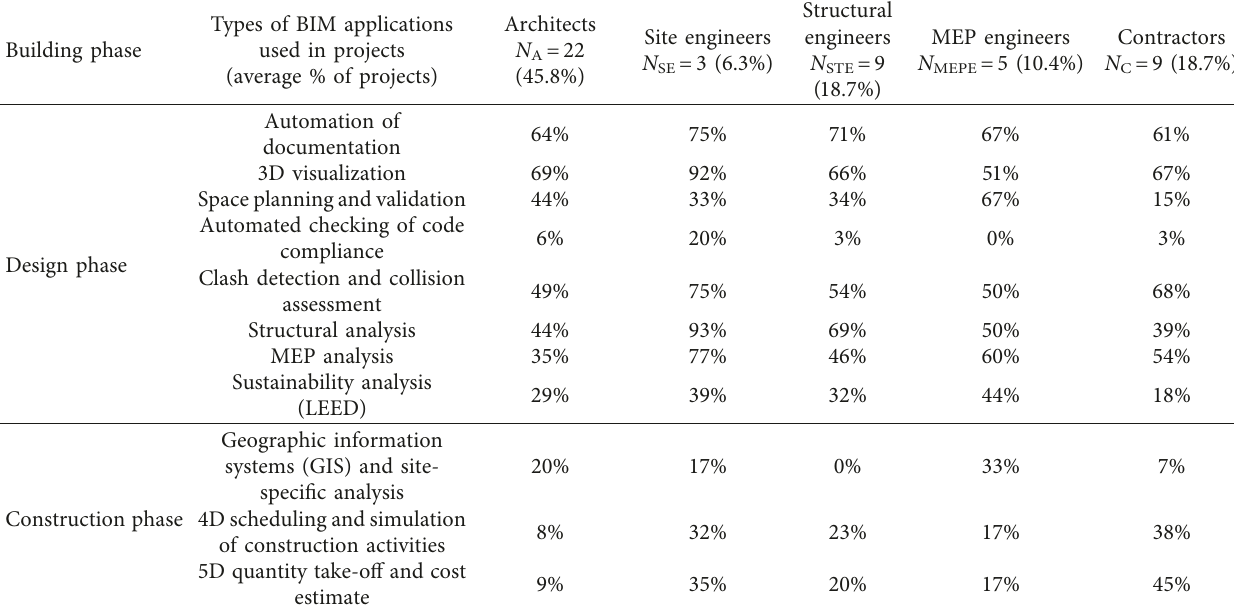
Table 6: Relationship between the role of the respondent and the average percentage of educational facility projects in which they have used the specific BIM applications in the previous five years by the project